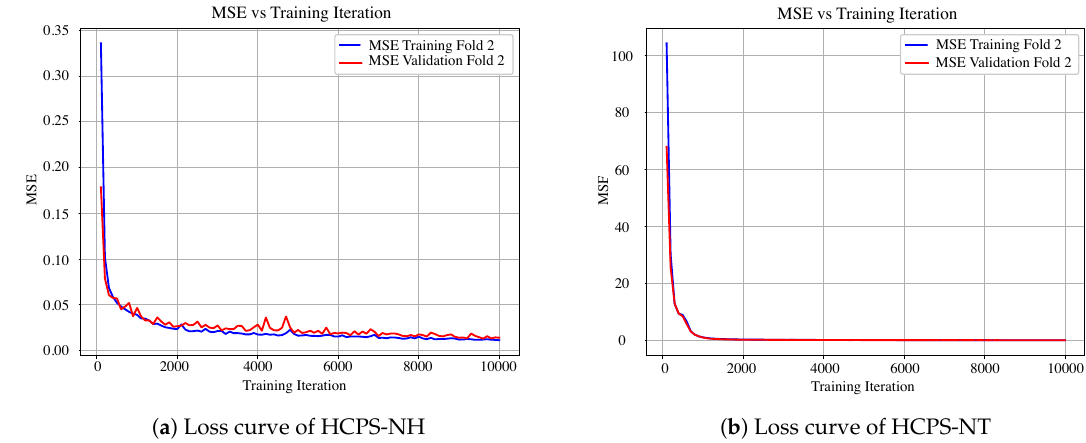
Figure 11. Loss curves for HCPS structures. Loss values correspond to MSE values from comparing real and predicted outputs throughout the training